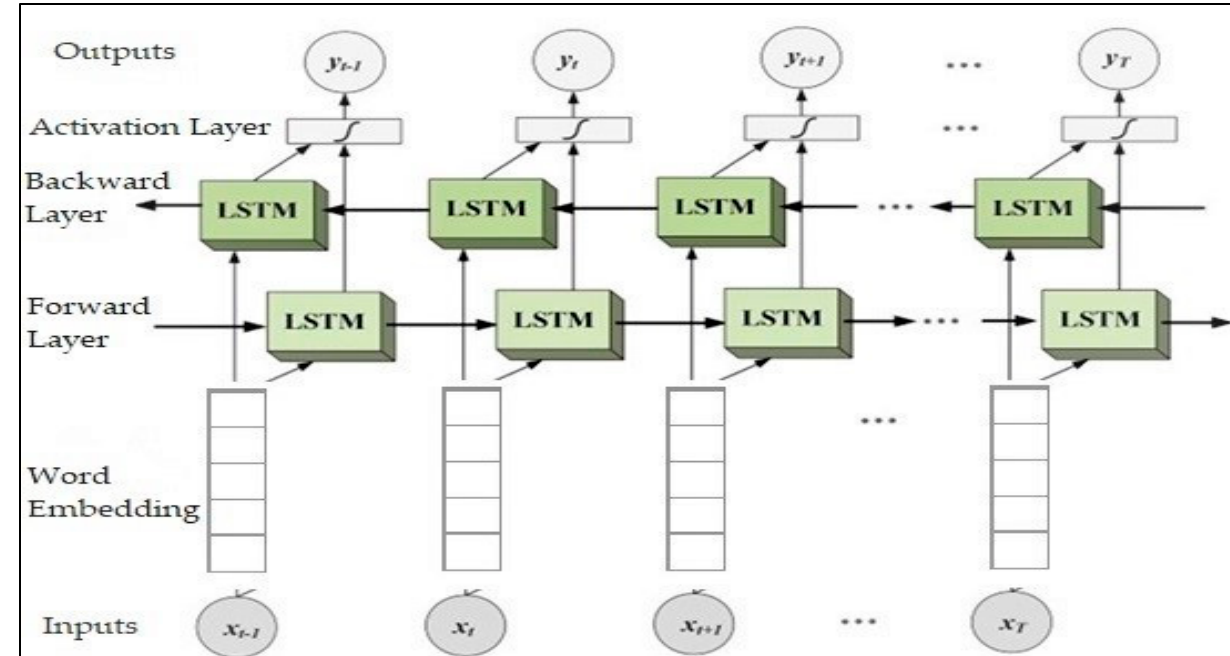
Figure 11. The basic architecture of Bi-LSTM uses word embedding.